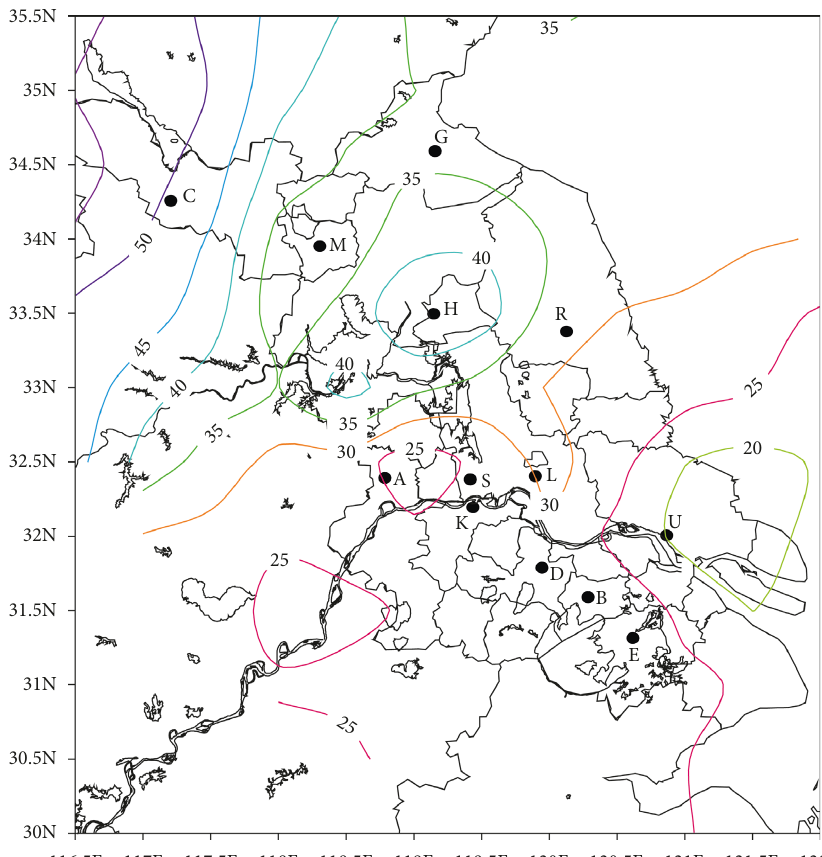
Figure 7: Spatial distribution of AQI differences between winter and summer over Jiangsu Province in the period 2013–2017. Table 2: Correlation coefficient of AQI in each season with every single meteorological parameter in Jiangsu Province in the period 2013-2017.